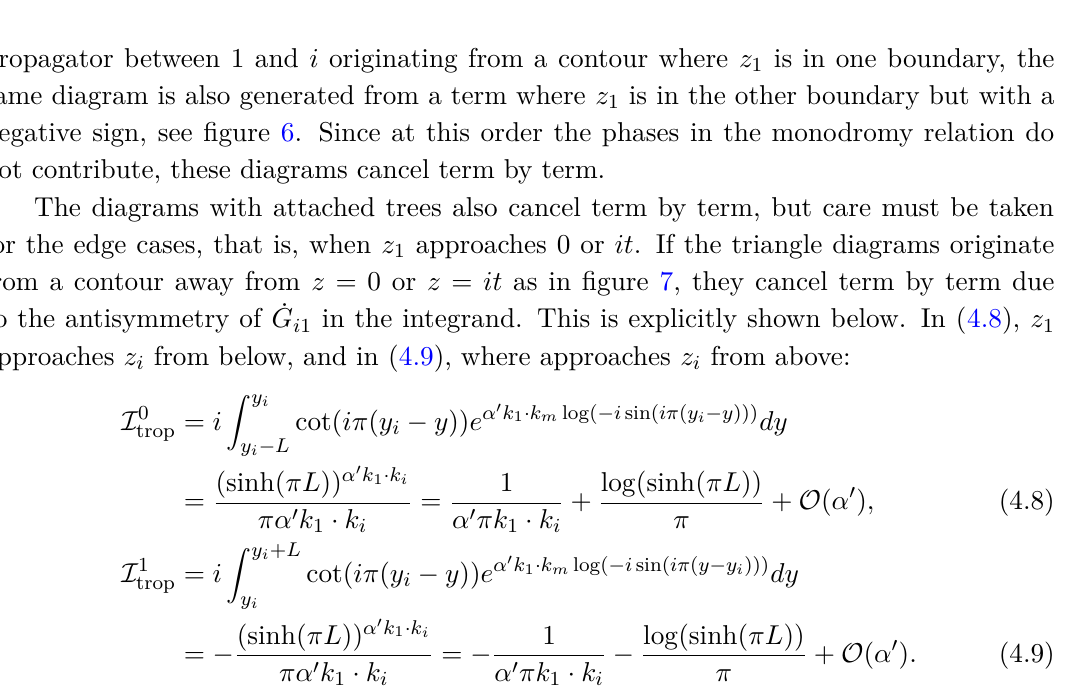
Figure 7 . Graphs with attached trees that cancel each other due to a relative minus